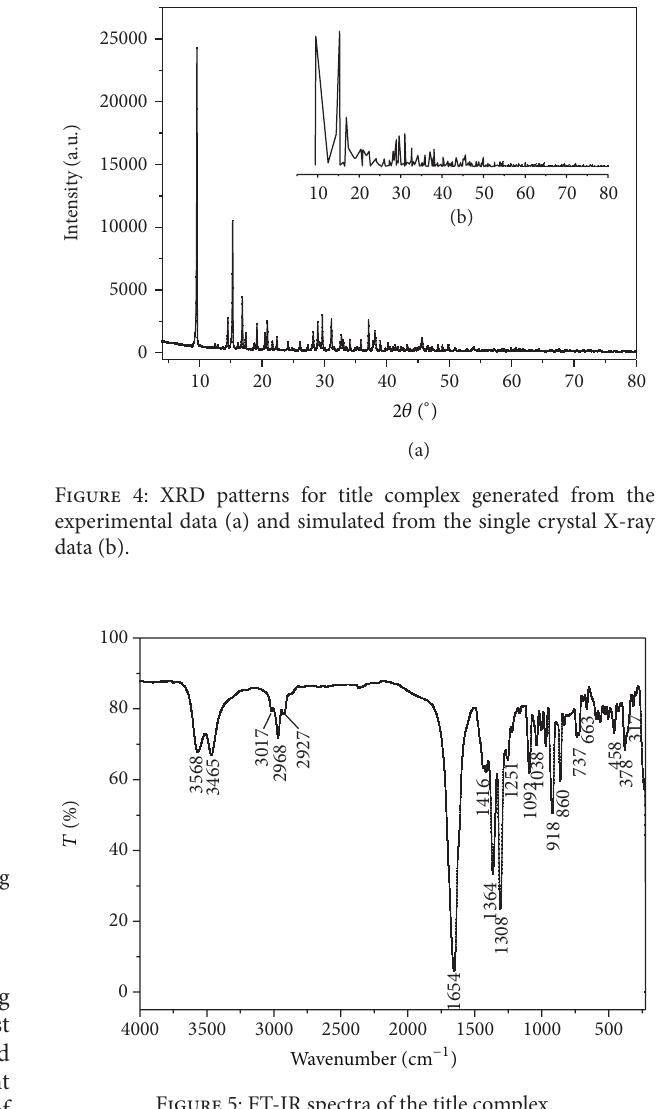
Figure 5: FT-IR spectra of the title